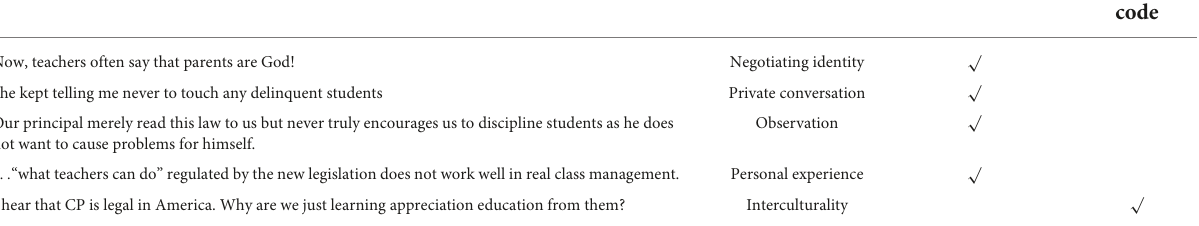
TABLE 3 Sample of the coding